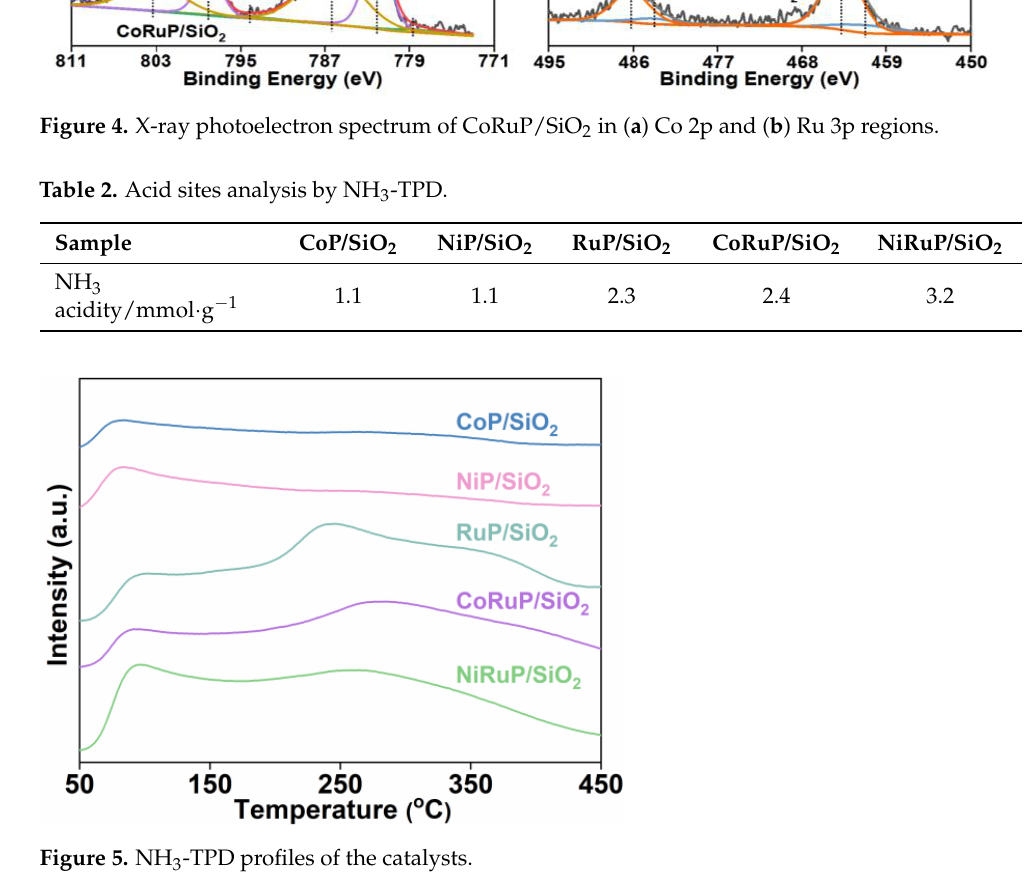
Figure 5. NH 3 -TPD profiles of the catalysts.